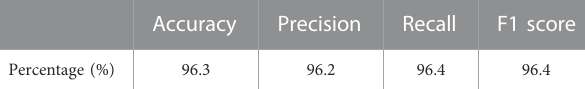
FIGURE 10 Accuracy results of the sensitivity analysis.